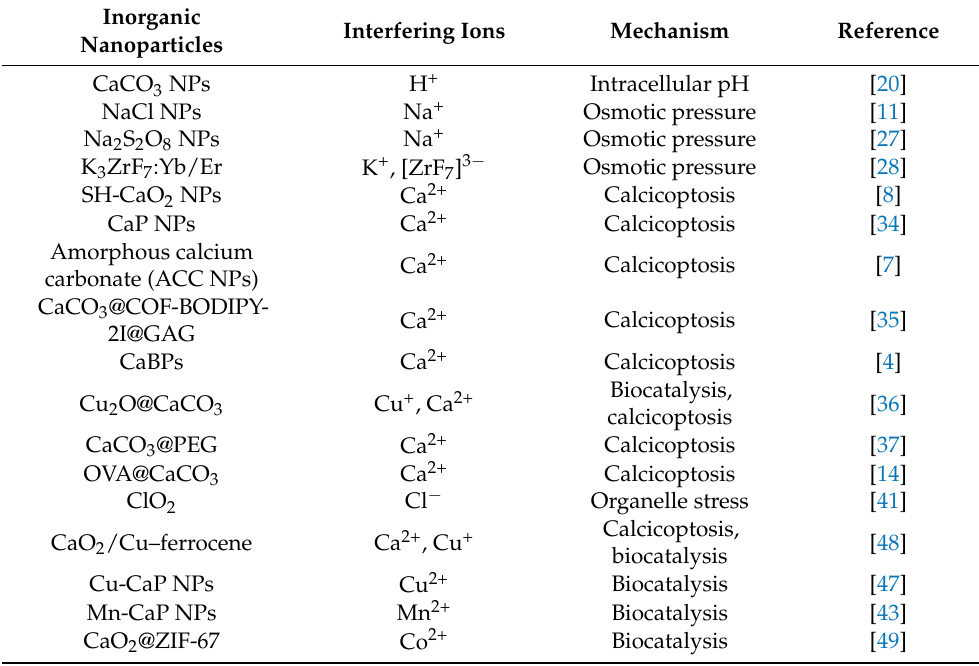
Table 1. The classification of inorganic nanomaterials for IIT. Inorganic Interfering Ions Nanoparticles